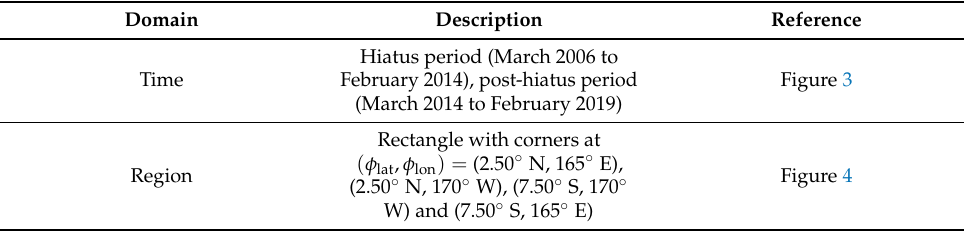
Table 1. Region of interest and time